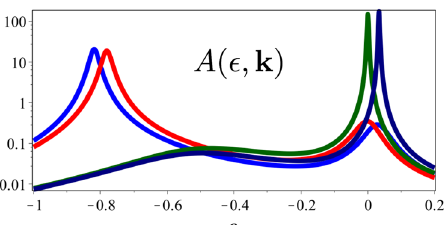
Fig. 4 Spectral function crossing Luttinger and Fermi surfaces. Physical electron DOS with the same parameters as in Fig. 2 apart from Δ = 0.1, a value at which ϵ ( k ) ϵ * ( k ) = − Δ 2 has real solutions. The different curves refer to the k -points along Γ → M shown in Fig. 3. Speci fi cally, the blue curve is on the Luttinger surface, the red at the inner border of the Fermi pocket, the dark green at the outer border, and, fi nally, the dark blue on the non-interacting Fermi surface. Note the much greater height of the zero- energy peak for k close to the non-interacting Fermi surface than to the Luttinger